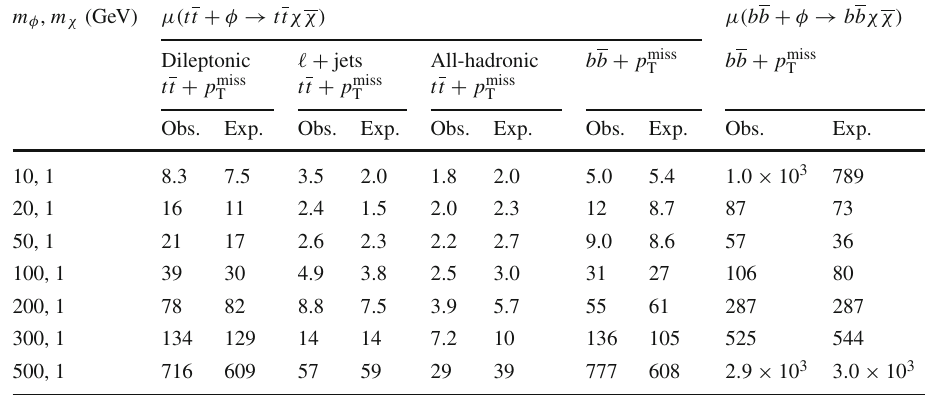
Table 6 Same as Table 5, but for DM mediators with pseudoscalar couplings. Again, mediator couplings correspond to g q = g χ =